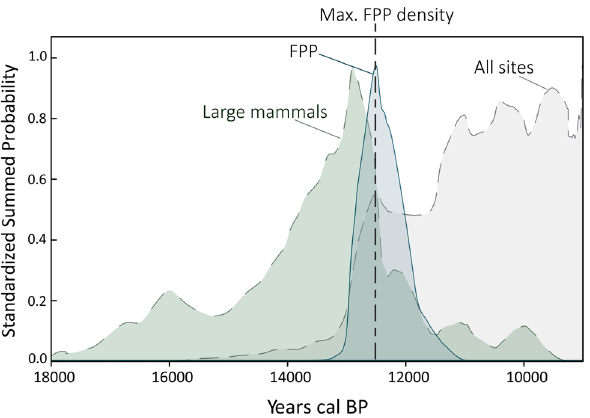
Fig. 1 Summed probability distribution curves for South America. The temporal change in the density of large mammals (or megafauna) (light green shading), FPP (light-blue shading), and archeological sites (beige shading) re fl ected in the SCPD curves for all of South America. X axis represents Calibrated years BP and Y axis the standardized summed probability.